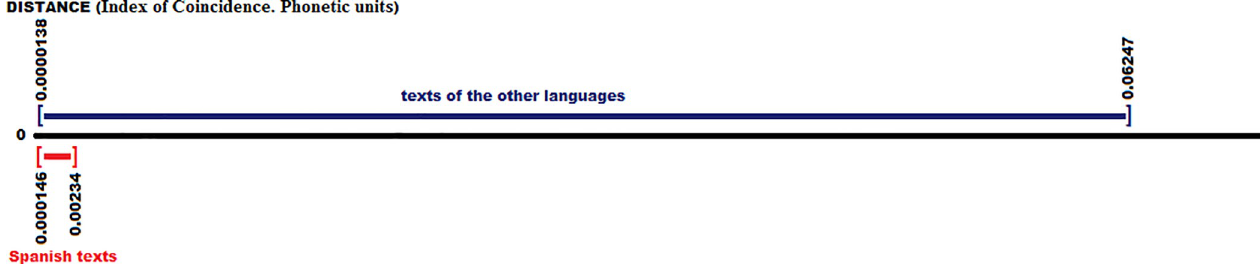
Fig 13. Index of Coincidence of the texts in Spanish or Castilian (phonetic units) (red) versus the rest of the texts (blue).